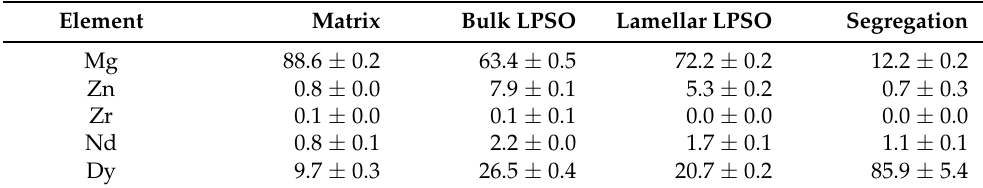
Table 3. Chemical composition of the different phases found on average in water-quenched platelets in wt.% with indication of the standard deviation